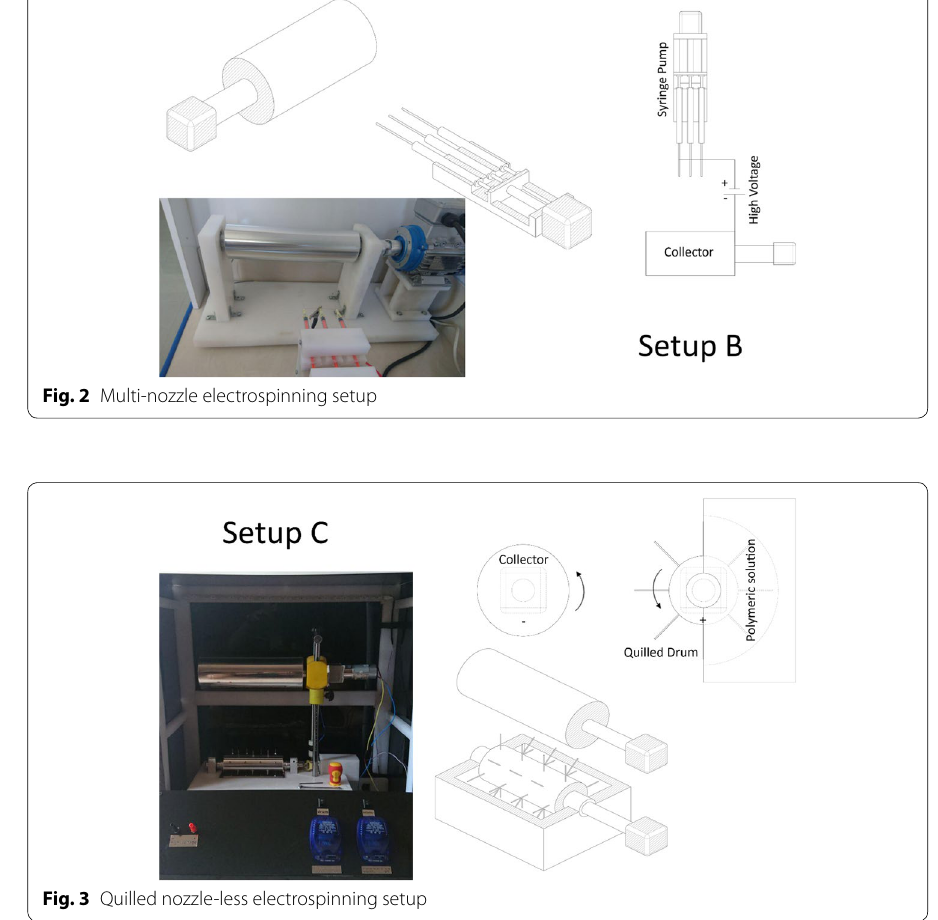
Table 1 Electrospinning parameters Electrospinning type Voltage (kV) Distance to collector (cm) Feeding Single nozzle 15 15 0.5